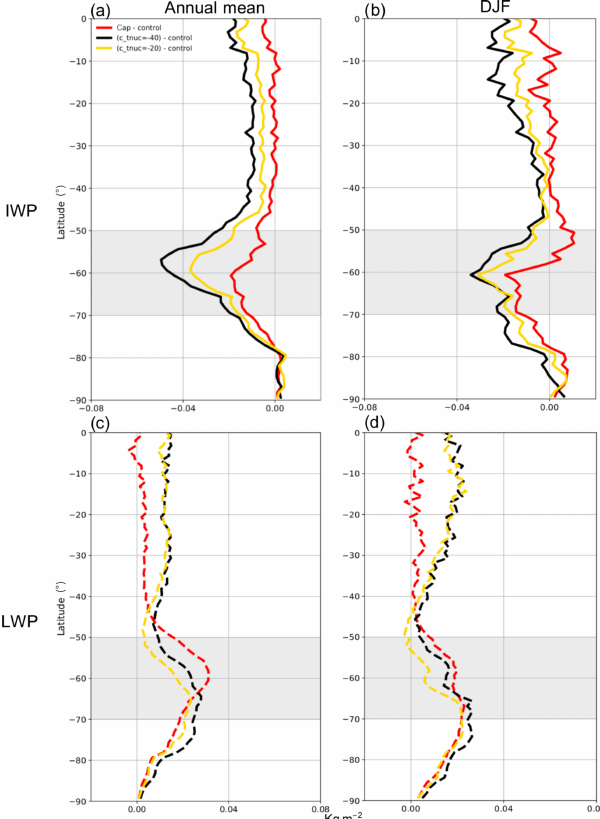
Figure 1. Distribution of zonally averaged anomalies in IWP (solid lines in panels a and b ) and LWP (dashed lines in panels c and d ) over the stratocumulus boundary-layer-type clouds in the model for the SH. Panels (a) and (c) represent annual mean; (b) and (d) rep- resent DJF mean. The colour codes are as follows: red indicates the anomaly of cap with respect to control, black indicates the anomaly of c_tnuc=-40 with respect to control, and yellow indicates the anomaly of c_tnuc=-20 with respect to control. Values are calcu- lated from 12-hourly instantaneous model output over 22 years. The SO region identified in this study is highlighted in